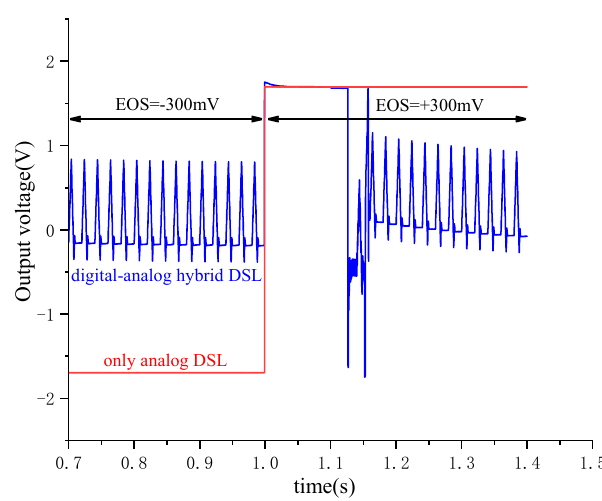
Figure 11. The transient waveform of the ECG amplifier with and without digital DSL.